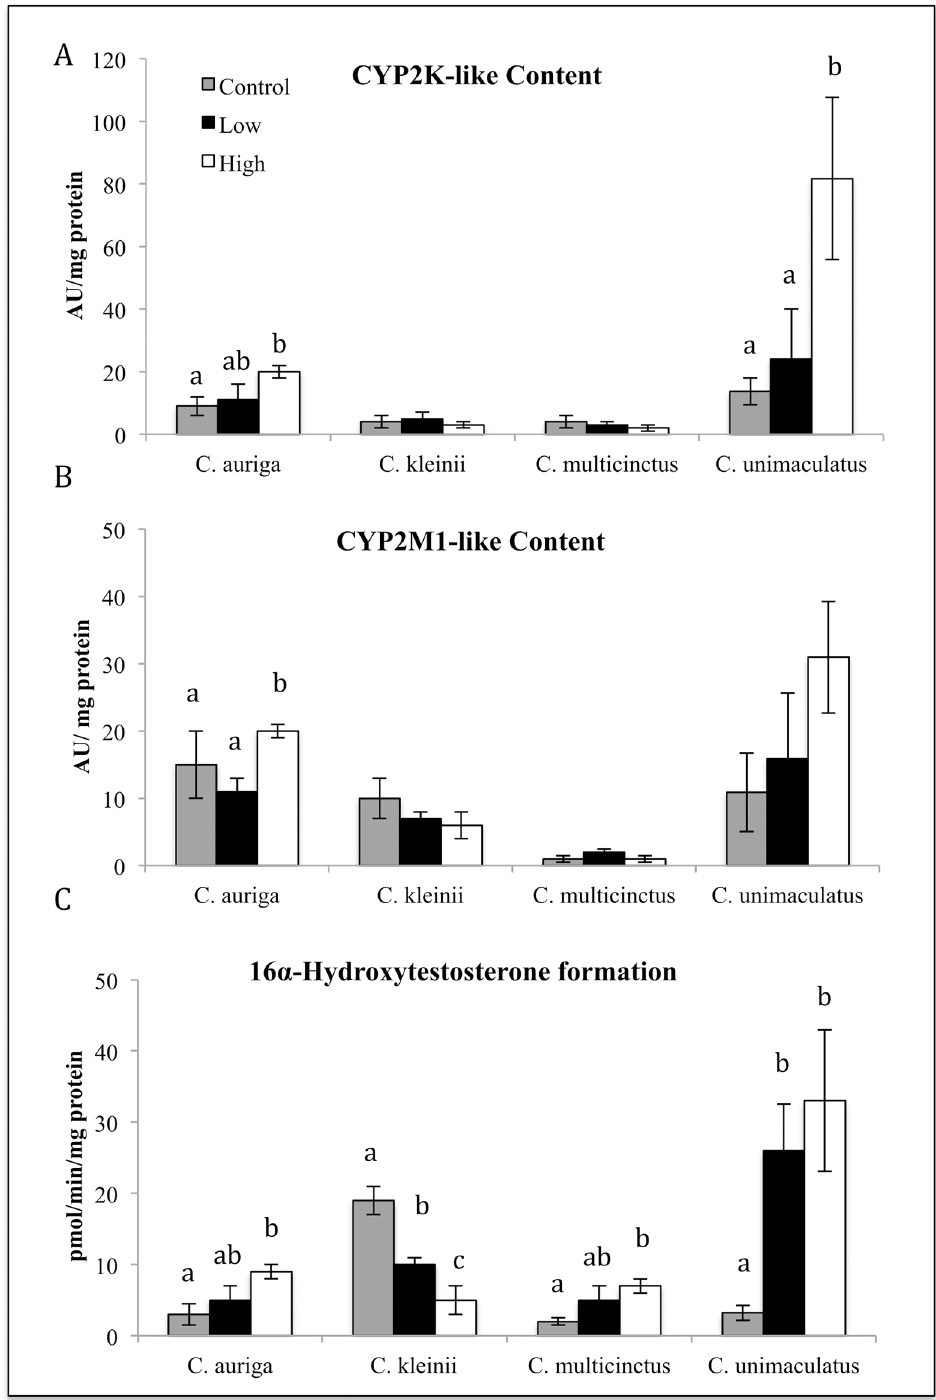
Fig 2. Effects of dietary exposure to S . maxima tissue homogenate on the hepatic content CYP2K1-like and CYP2M1-like (A, B) and catalytic activity (C) of and CYP2 in four species of butterflyfish. Different letters indicate significant (P (cid:1) 0.05) differences between untreated and treated fish (N = 6 – 8).